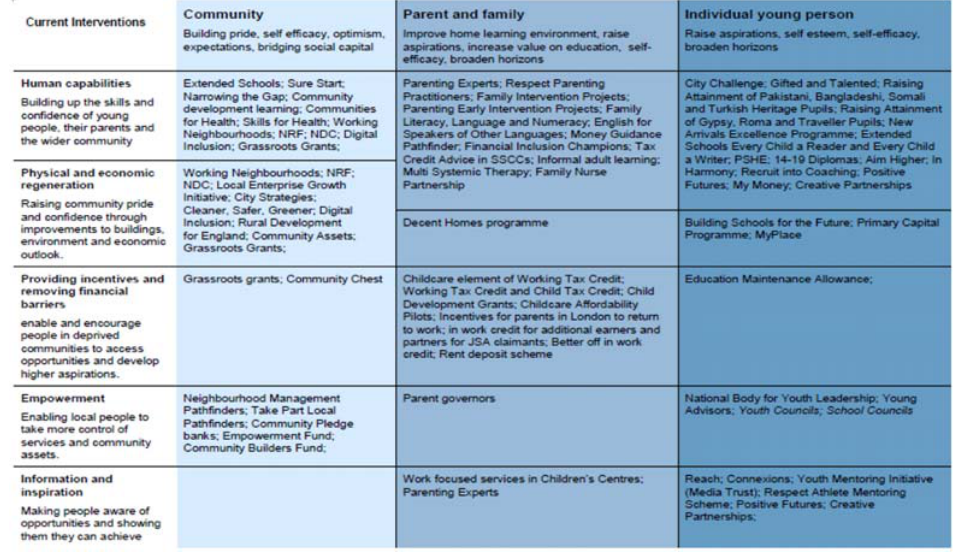
Figure 1. Summary of 2010 Labour government policy related to aspiration, taken from Social Exclusion Taskforce